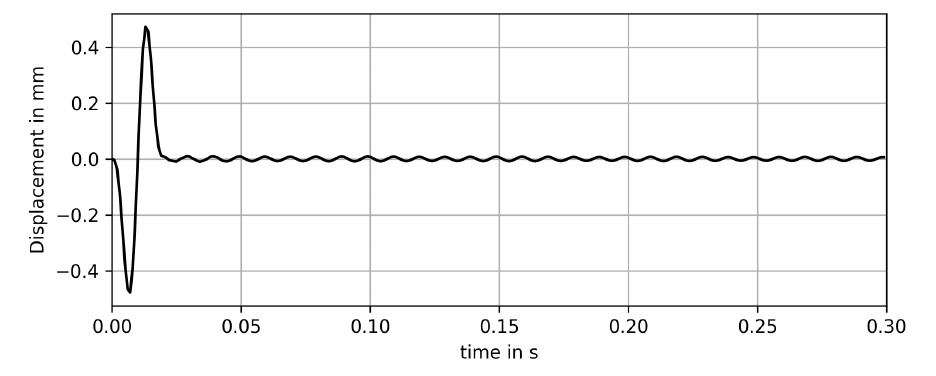
Figure 10. Structural response at frequency f exc = 50.00Hz.